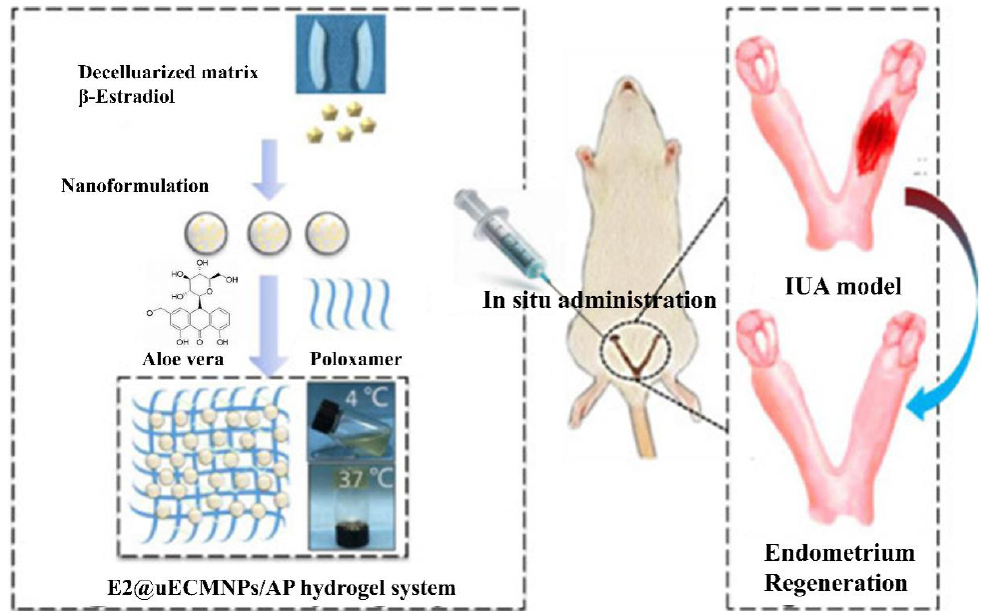
Figure 9. Schematic graphs of E2@uECMNPs/AP hydrogel system to promote endometrial regen- eration for the prevention of IUA. The image has been taken from the publication by Yao et al. [93] with permission.